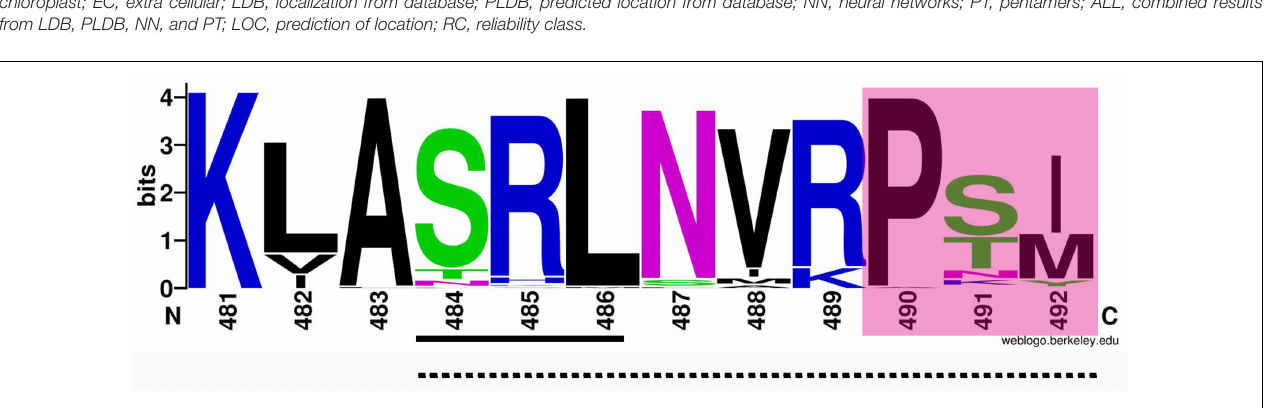
amino acids, as a non-canonical PTS1, to target the enzyme to